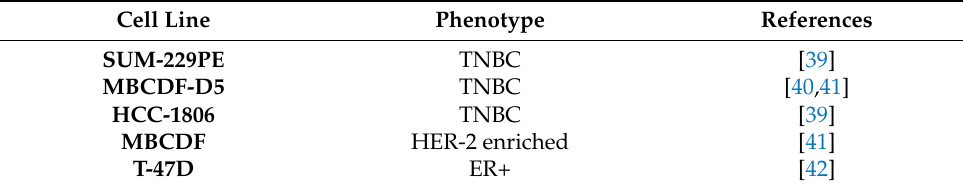
Table 1. Breast cancer cells